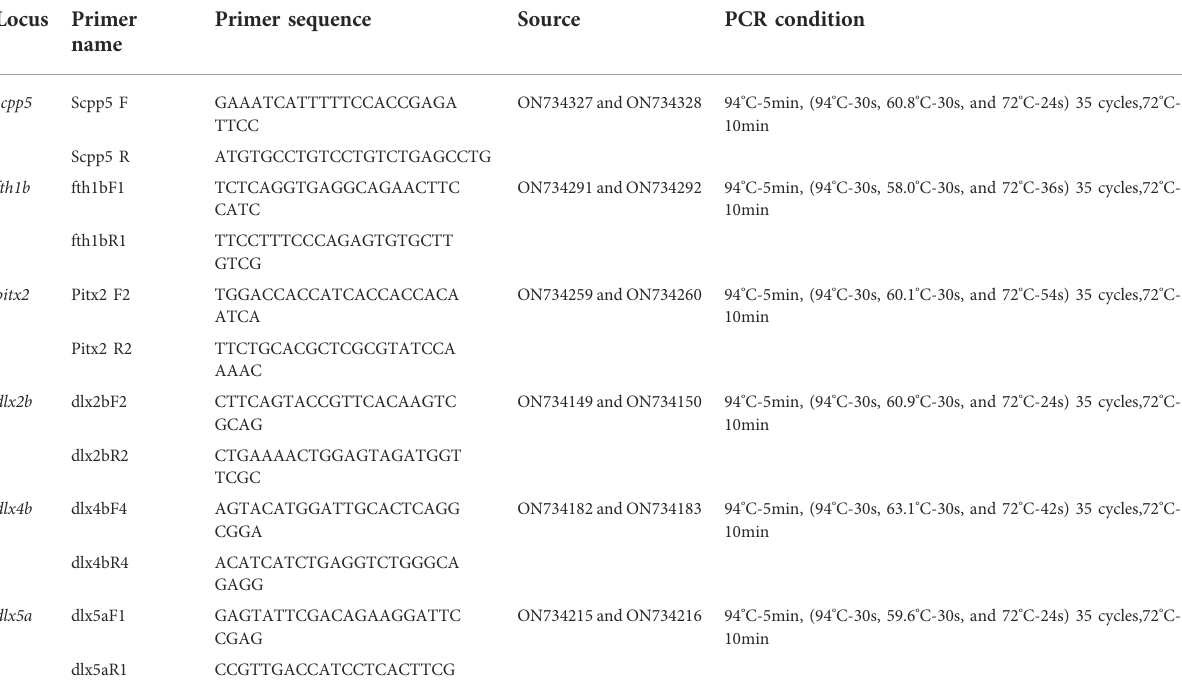
TABLE 1 Primers used in this study and PCR